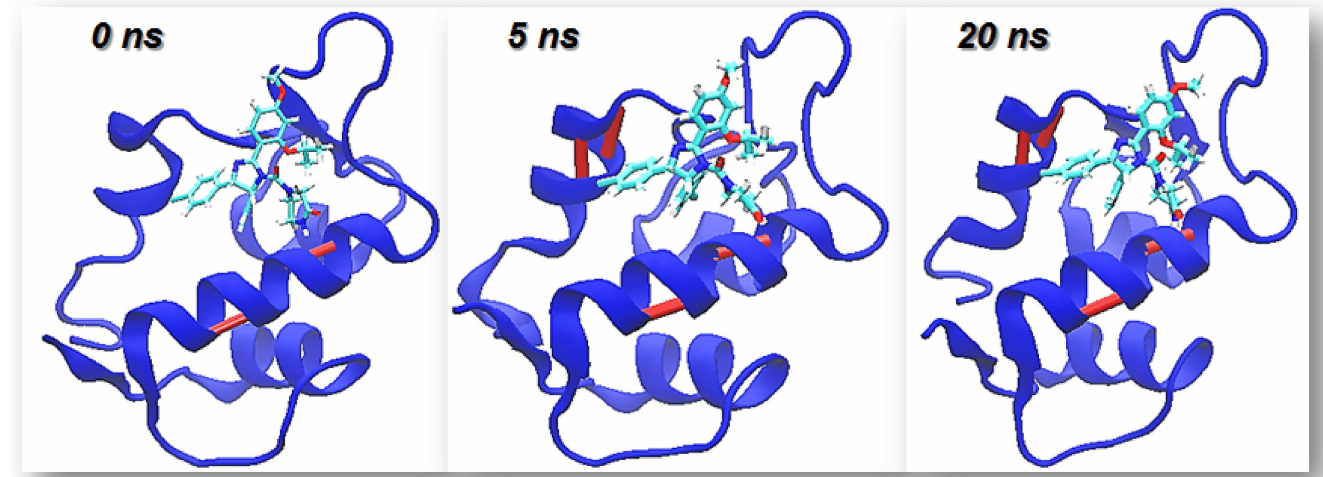
Fig 1. Different snapshots of the simulation of the interaction of MDM2 apo with Nutlin-3a illustrating the timescalesof stabilization of the different C-HBs. If the C-HB is formed it is indicatedby a bar colored in maroon.